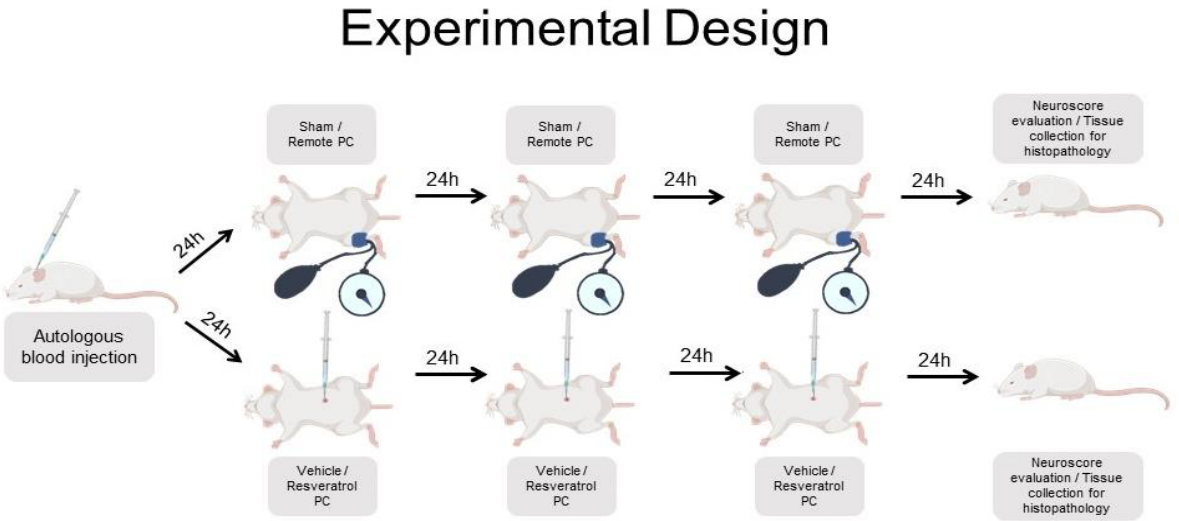
Figure 1. Overview of the experimental design. (PC =